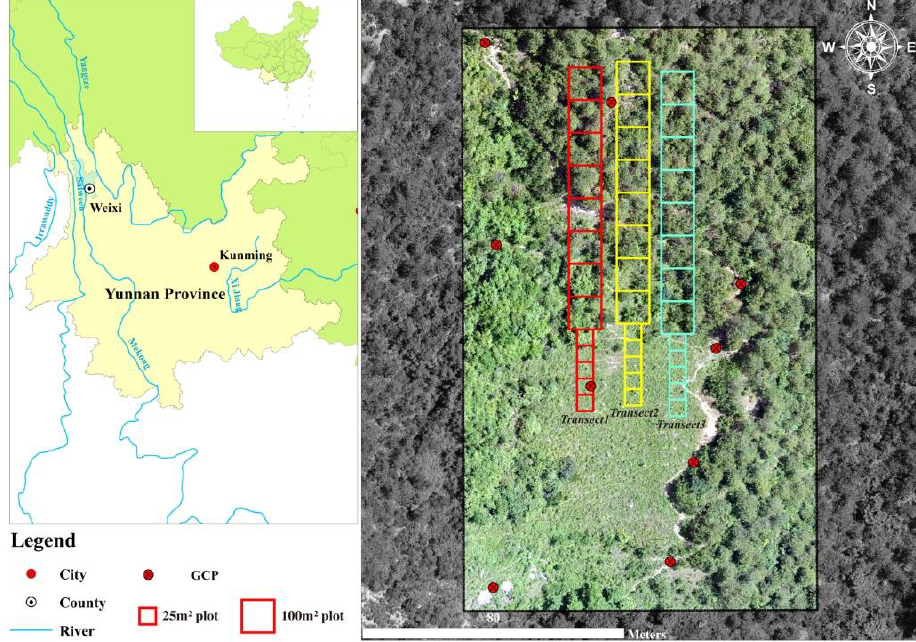
Figure 1. Location of the sample plot. The right pic is the Baijixun sample plot, Weixi, with 19,203 m 2 . Furthermore, here are three sample transects that were be set up along the slope.